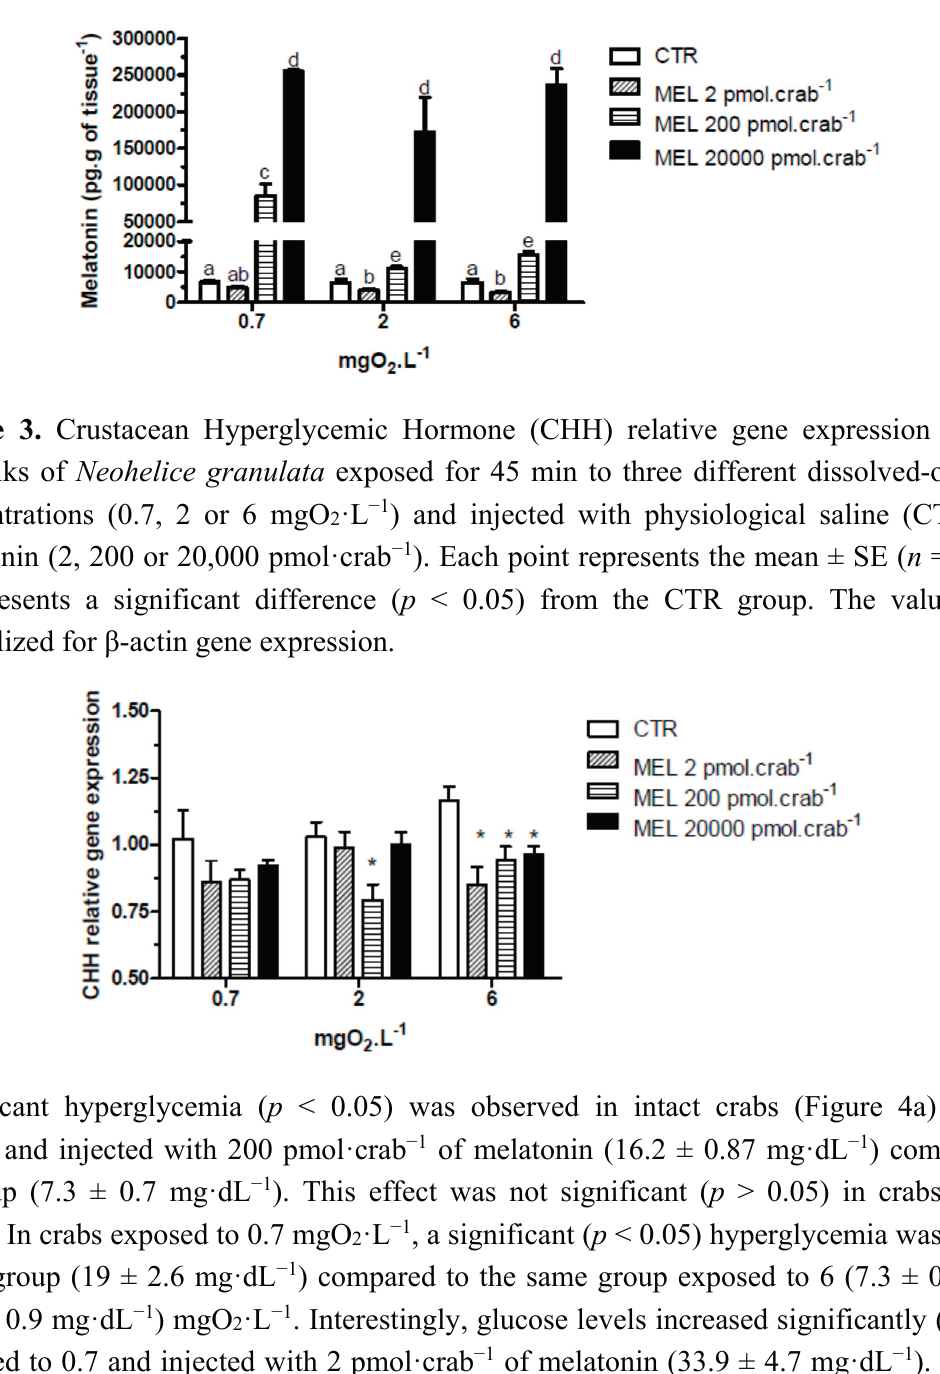
Figure 2. Melatonin content in the eyestalks of the crab Neohelice granulata exposed for 45 min to three different dissolved-oxygen concentrations (0.7, 2 or 6 mgO 2 ·L − 1 ) and injected with physiological saline (control group—CTR) or melatonin (2, 200 or 20,000 pmol·crab − 1 ). Each point represents the mean ± SE ( n = 3–4). Different letters represent significant differences ( p < 0.05) between the groups.